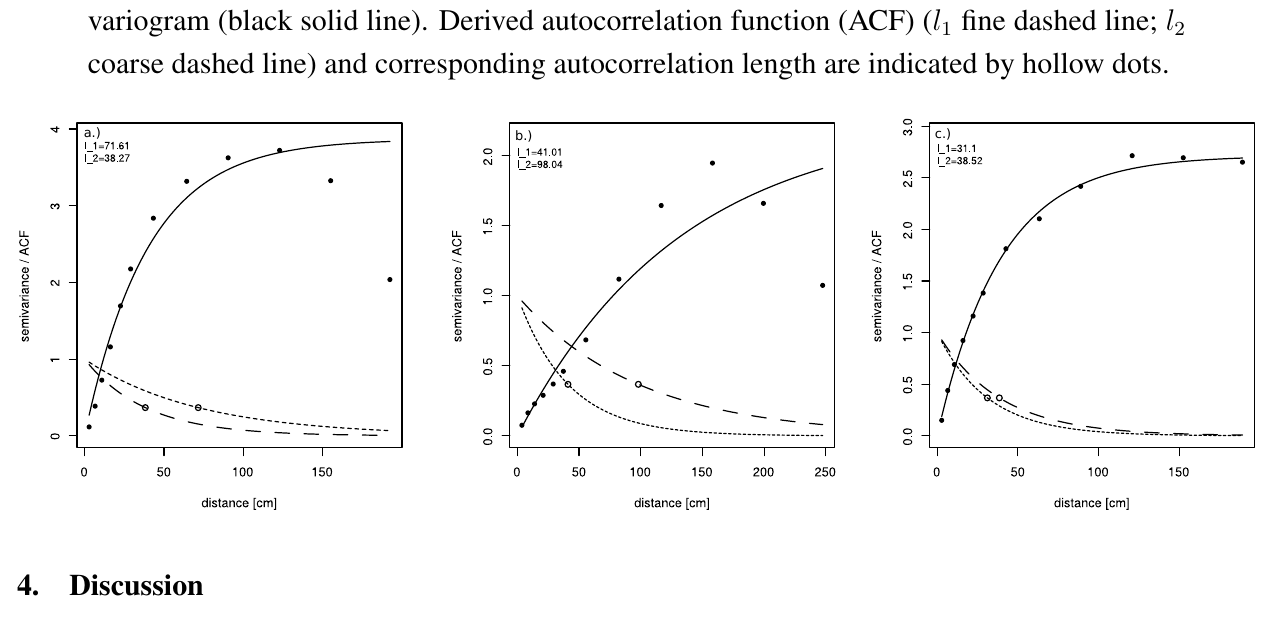
fine dashed line; l 1 2